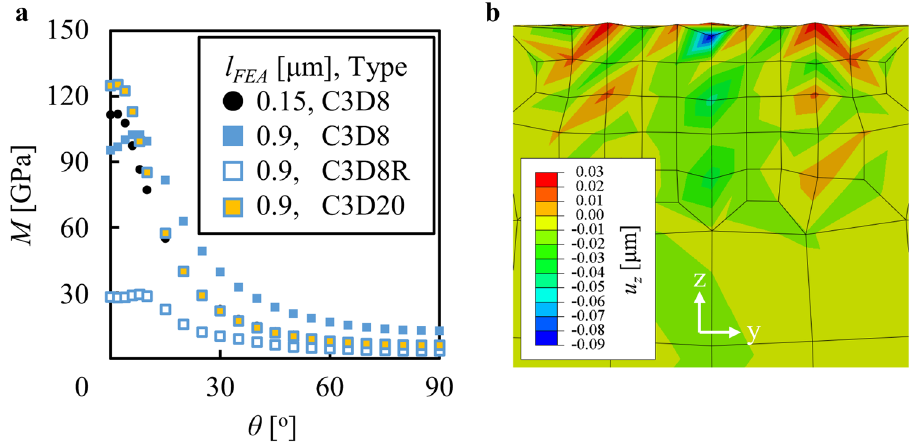
Fig. 9 Distributions of displacements ( u and c , f plots at x = y = 0 µm, respectively